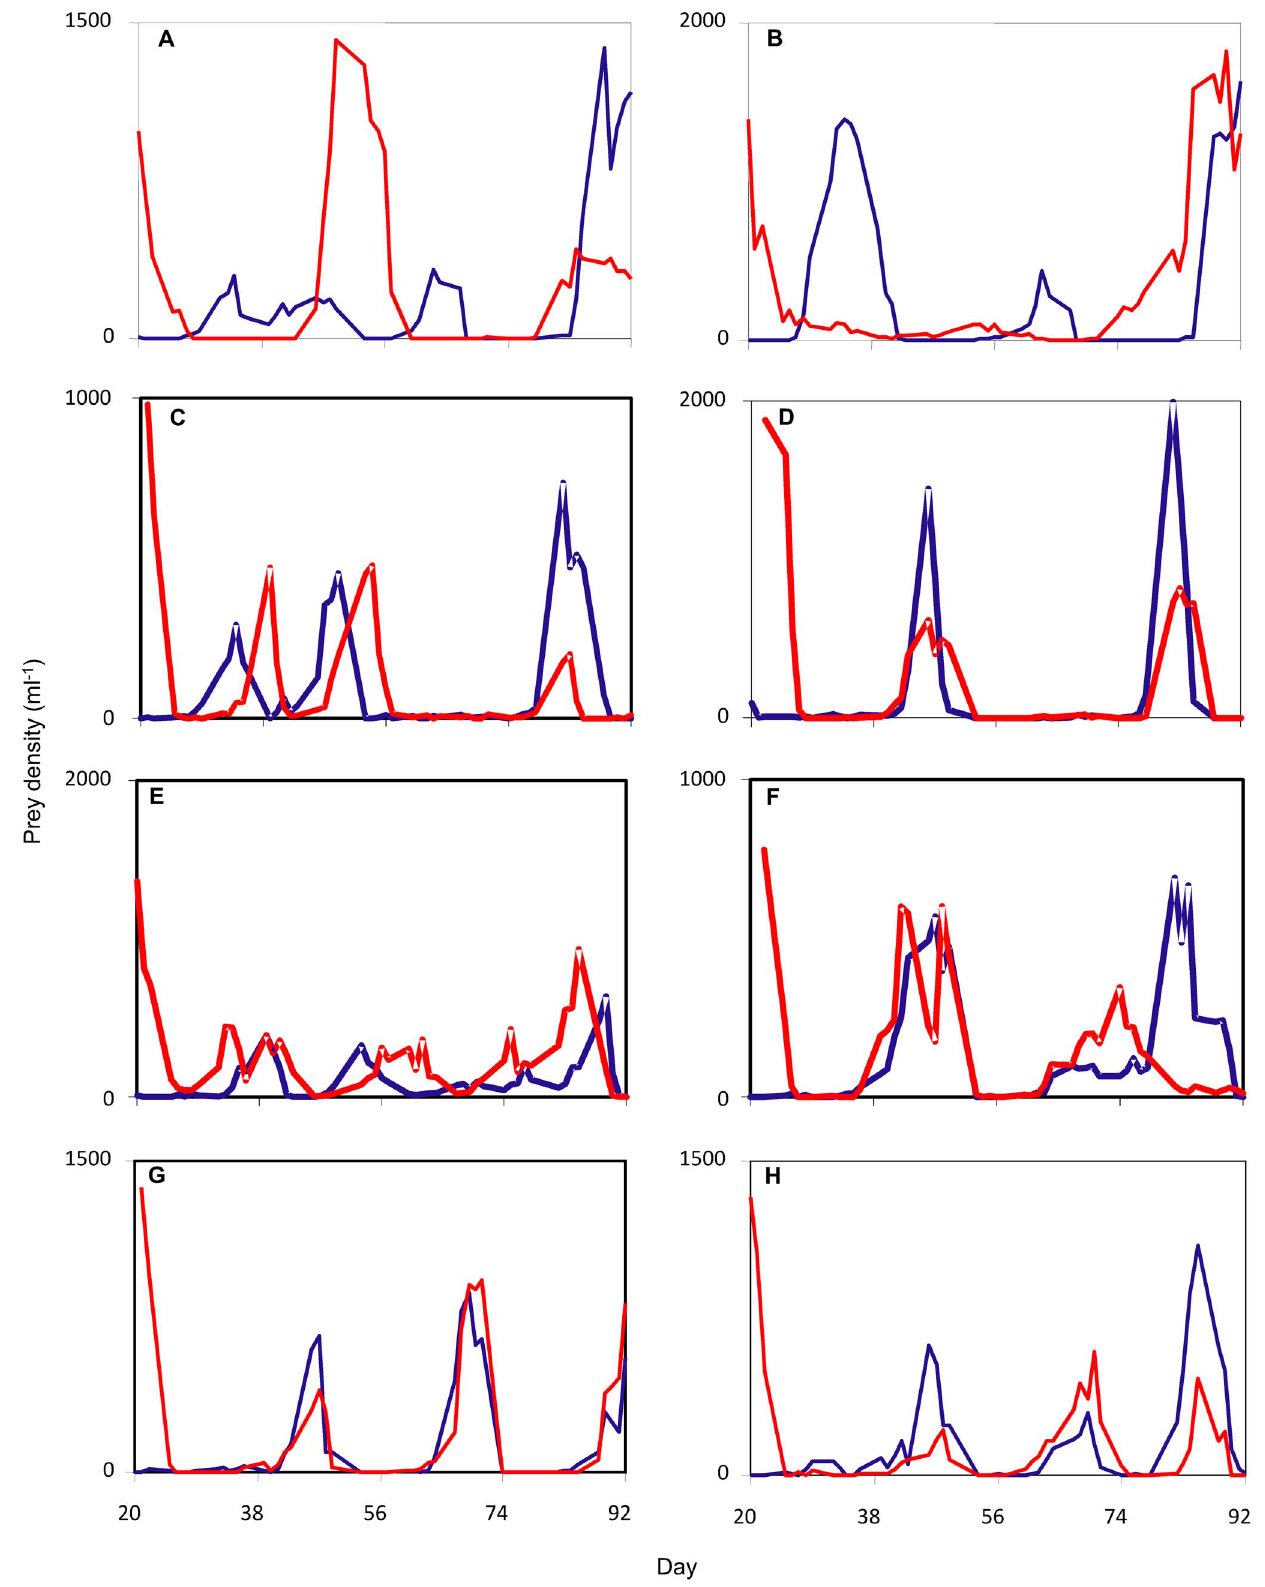
Figure 3. Representative prey population dynamics. Red and blue lines in each panel give prey dynamics in two patches linked by dispersal, starting from day 20 when dispersal was initiated. (a-d) Failure to achieve synchrony with a dispersal rate of 0.125% per event, (c) slow achievement of synchrony with a dispersal rate of 5% per event, (d) rapid achievement of synchrony with a dispersal rate of 5% per event, (e) failure to achieve